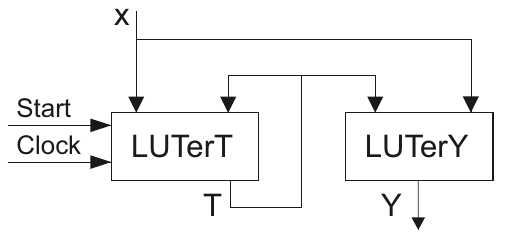
Figure 2. Structural diagram of LUT-based P Mealy